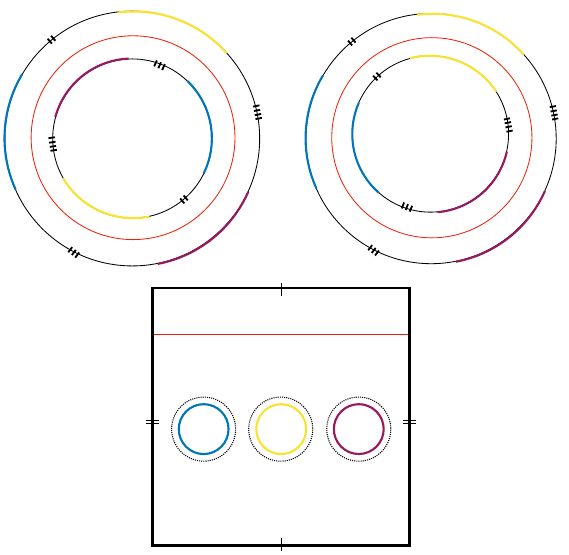
Figure 11 . Top left: P after gluing tab 1 . Top right: the annulus after rotation. Bottom: a topological representation of the manifold P . Shown are the three boundaries, b p P the dashed lines, and Σ P in